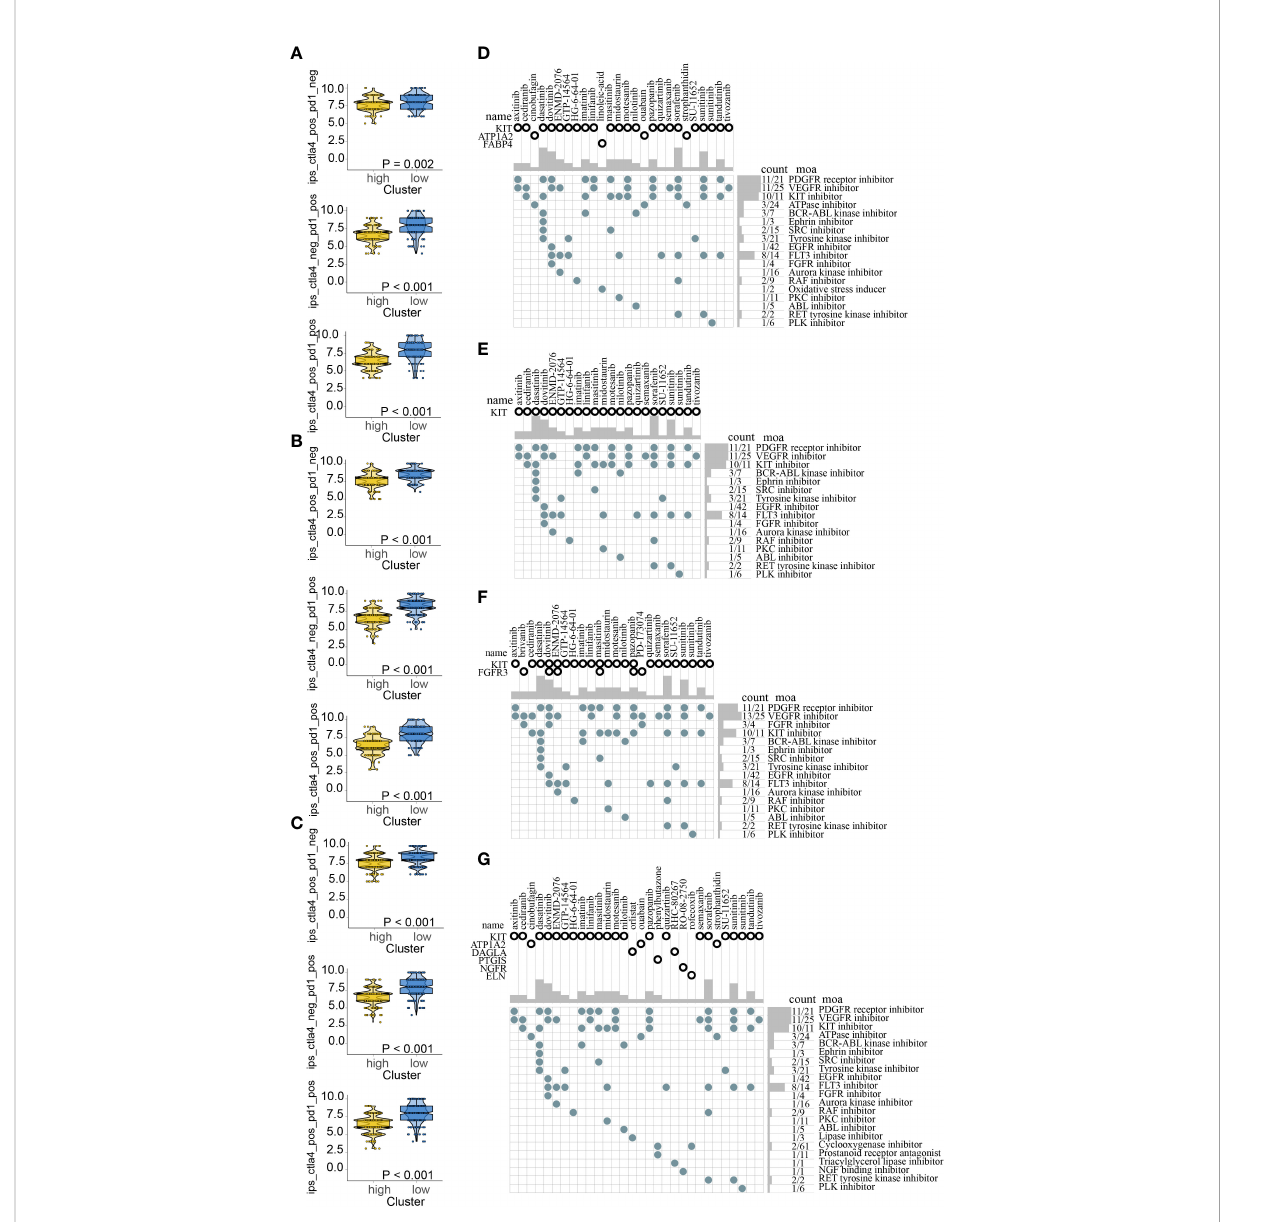
FIGURE 12 Immunotherapy response prediction in train (A) , test1 (B) , test2 (C) ; Potential drugs targeted the upregulated DEGs in high-risk for melanoma treatment based on ICDRS in train (D) , test1 (E) , test2 (F) , and test3 (G)